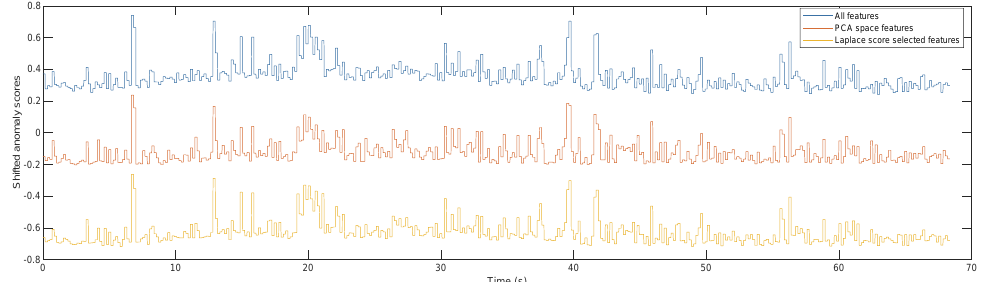
Figure 10. Example anomaly score for a no-squat case with different features. Table 3. MRSE calculation for different feature set. All Features vs. PCA vs. Laplacian Test Run All Features vs. PCA Laplacian MRSE MRSE